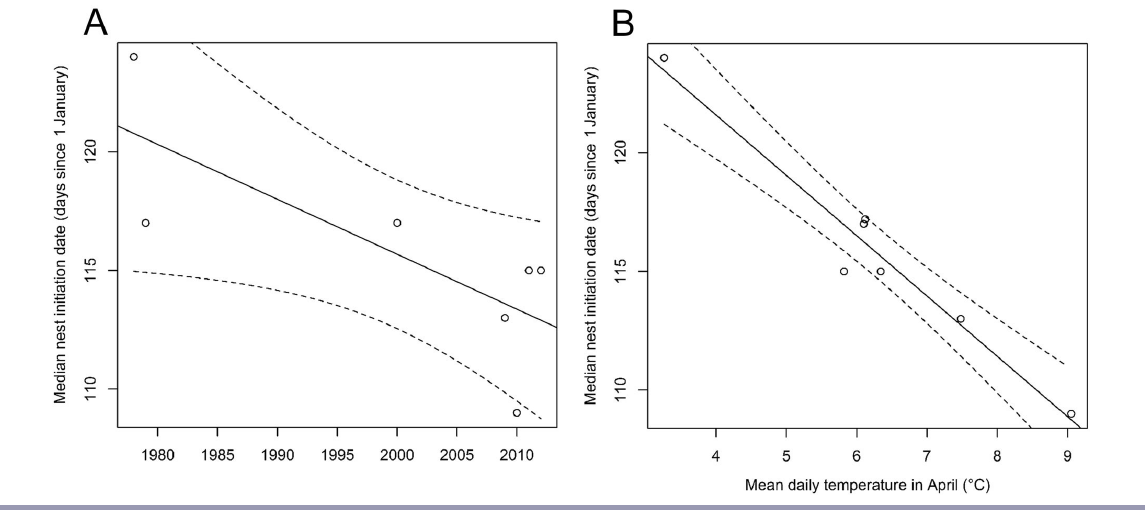
Fig. 2 . Median nest initiation date of Ring-billed Gulls ( Larus delawarensis ) at Île de la Couvée (1978, 2000), Petite Colonie (1979), and Île Deslauriers (2009-2012) (A), and the relationship with mean daily temperature in April (B). The solid line represents the regression function while the dashed lines represent the 95% confidence